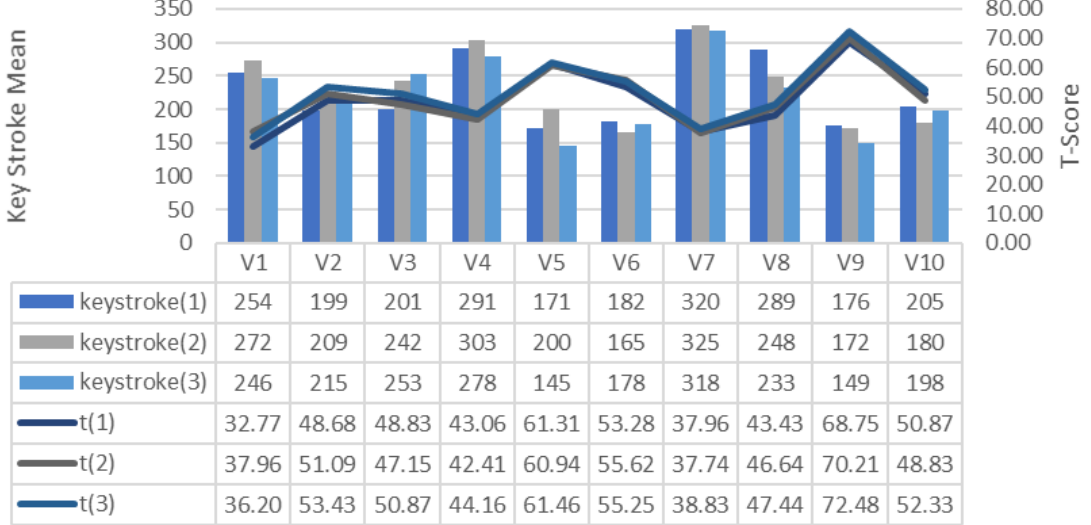
performance players have shorter game completion times on average and require fewer in the 3rd training, and the average of the V5 is 172. The average number of keystrokes of the V9 with the highest game performance average is 166.